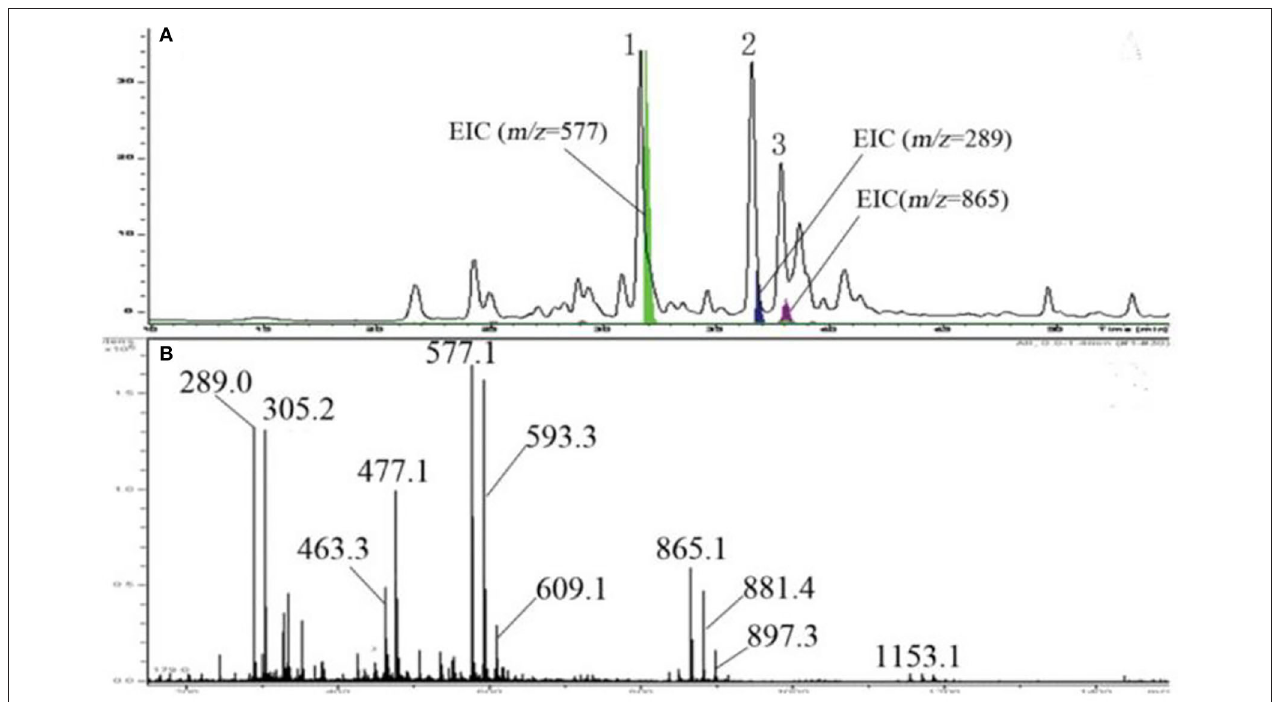
FIGURE 1 | HPLC chromatogram, EICs (A) , and mass spectrum (B) of LSOPC using